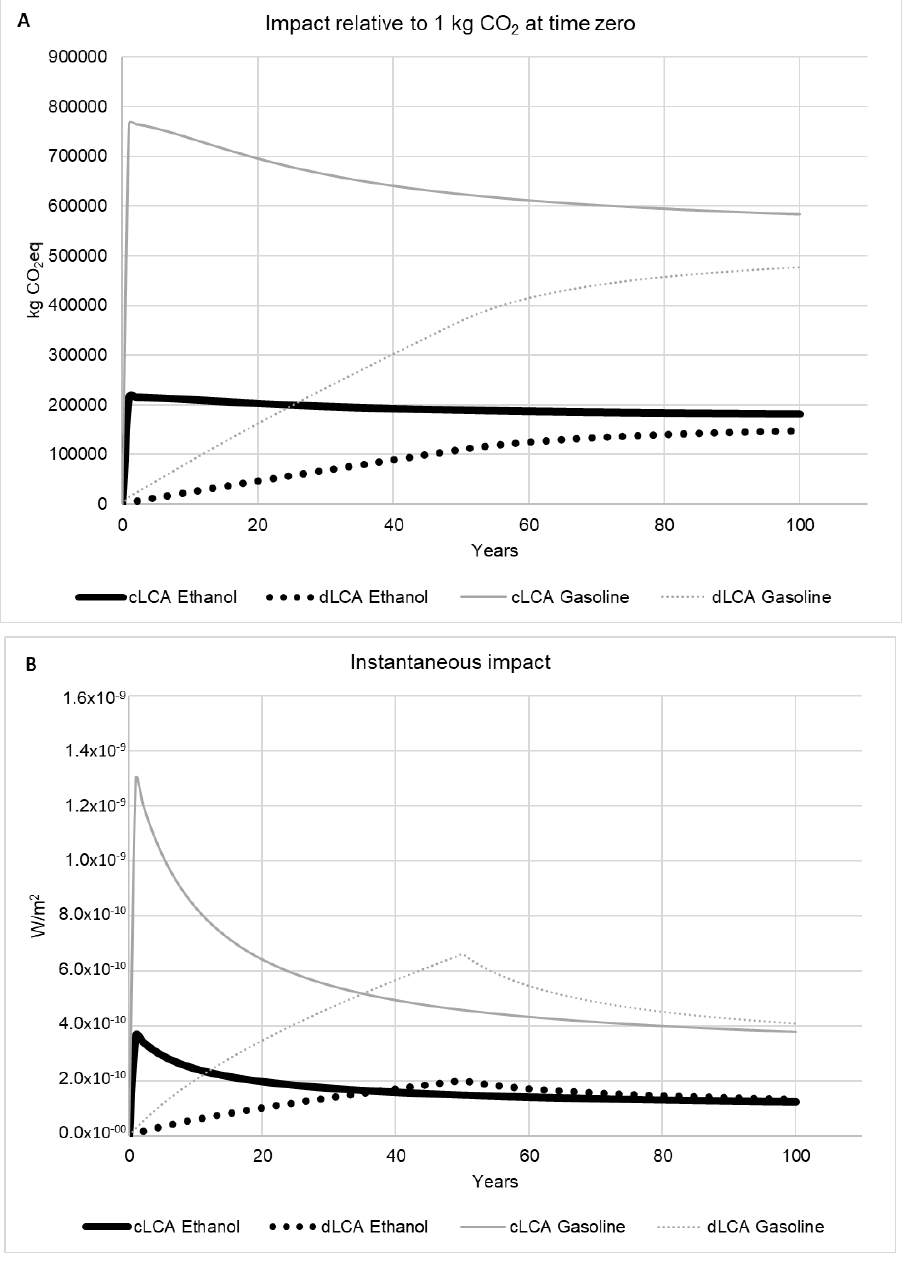
Figure 7. Relationship between biomass-to-ethanol and crude oil-to-ethanol equivalent (gasoline). ( A ) Comparison of GW impacts relative to 1 kg of CO 2 at time zero between conventional and dynamic scenarios of GHG emissions (see Equation (5)). ( B ) Comparison of GW instantaneous impacts between conventional and dynamic scenarios of GHG emissions (see Equation (4)).